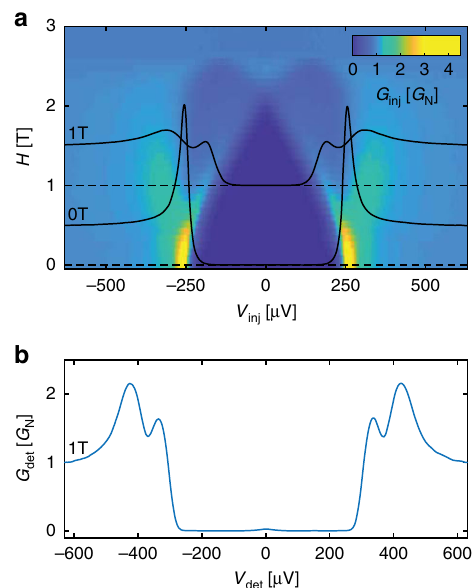
Fig. 2 Characterisation of injector and detector junctions. a Differential conductance of the injector junction ( G inj ) as a function of injector voltage ( V inj ) and magnetic fi eld ( H ), and horizontal slices at H = 0 T and H = 1 T (black traces). The quasiparticle density of states in the superconducting wire can be seen to be clearly Zeeman split at 1 T. b Differential conductance of the detector junction ( G ) as a function of the detector det voltage ( V det ) at H = 1 T without any injection current. As the detector is not Zeeman-split, we also see the Zeeman splitting of the quasiparticle density of states in the superconducting